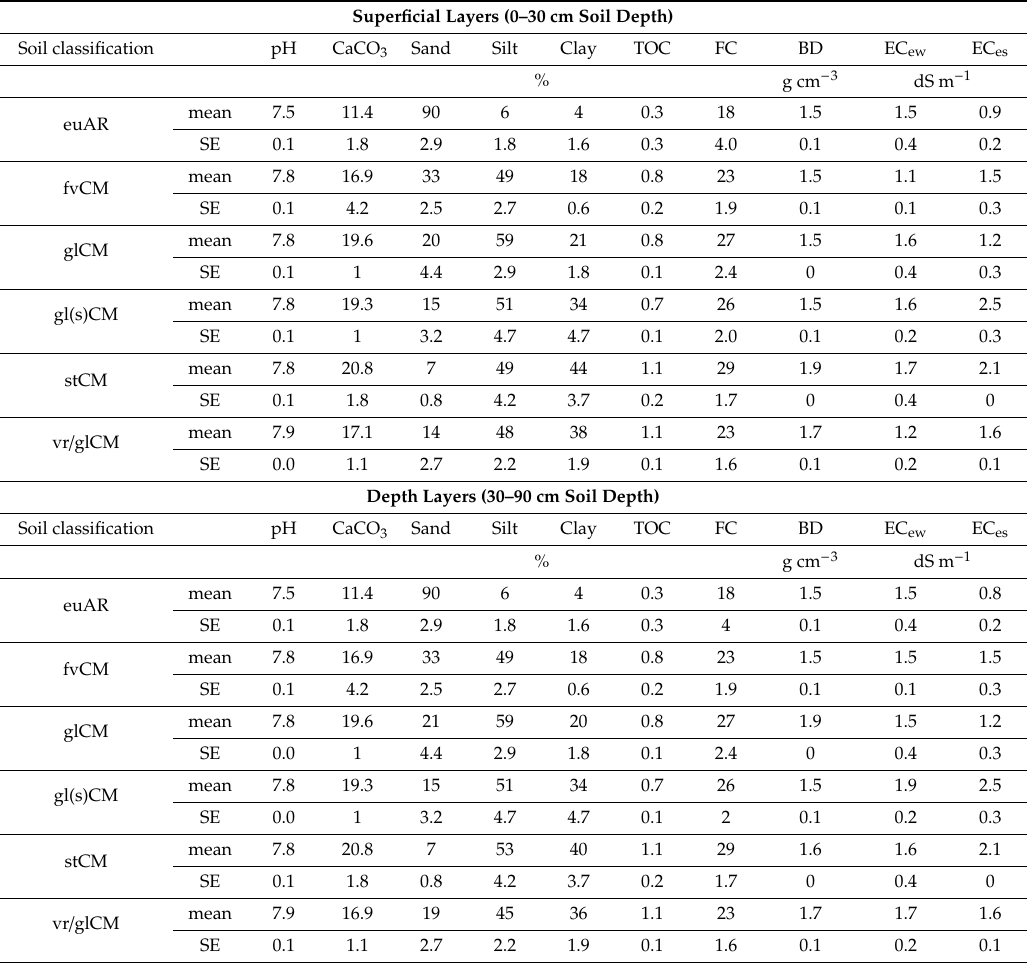
Table 2. Mean and standard error (SE) of pH, amounts of total organic C (TOC), carbonates (CaCO 3 ), sand, silt and clay, water content at field capacity (FC), water content of wilting point (WP), bulk density (BD), soil electrical conductivity in the non-irrigation winter period (EC ew ) and in the irrigation summer period (EC es ) for superficial layers and depth layers of the investigated